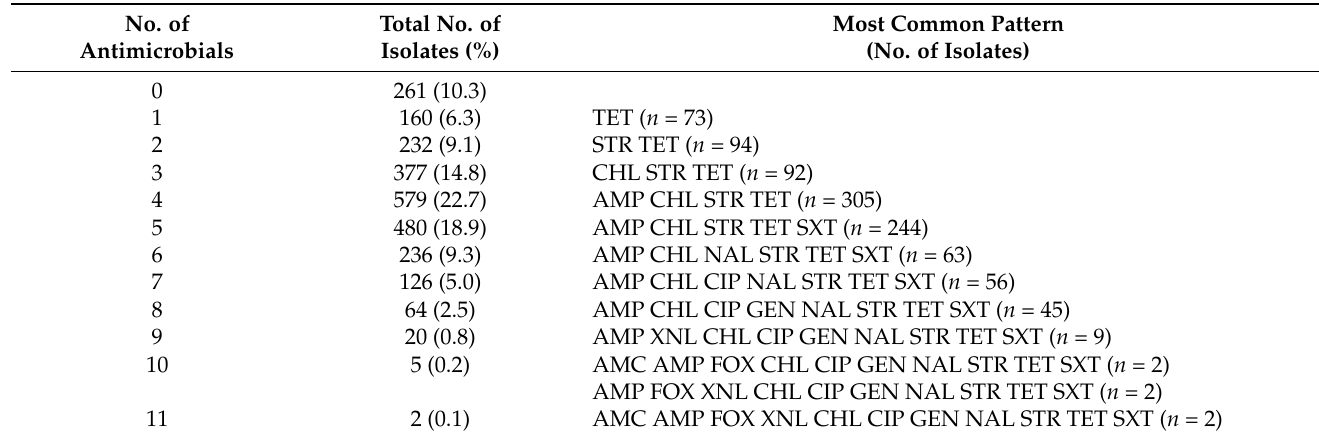
Table 4. Frequent resistance patterns in E. coli isolated from healthy pigs between 2010 and 2020 in Korea ( n = 2542).